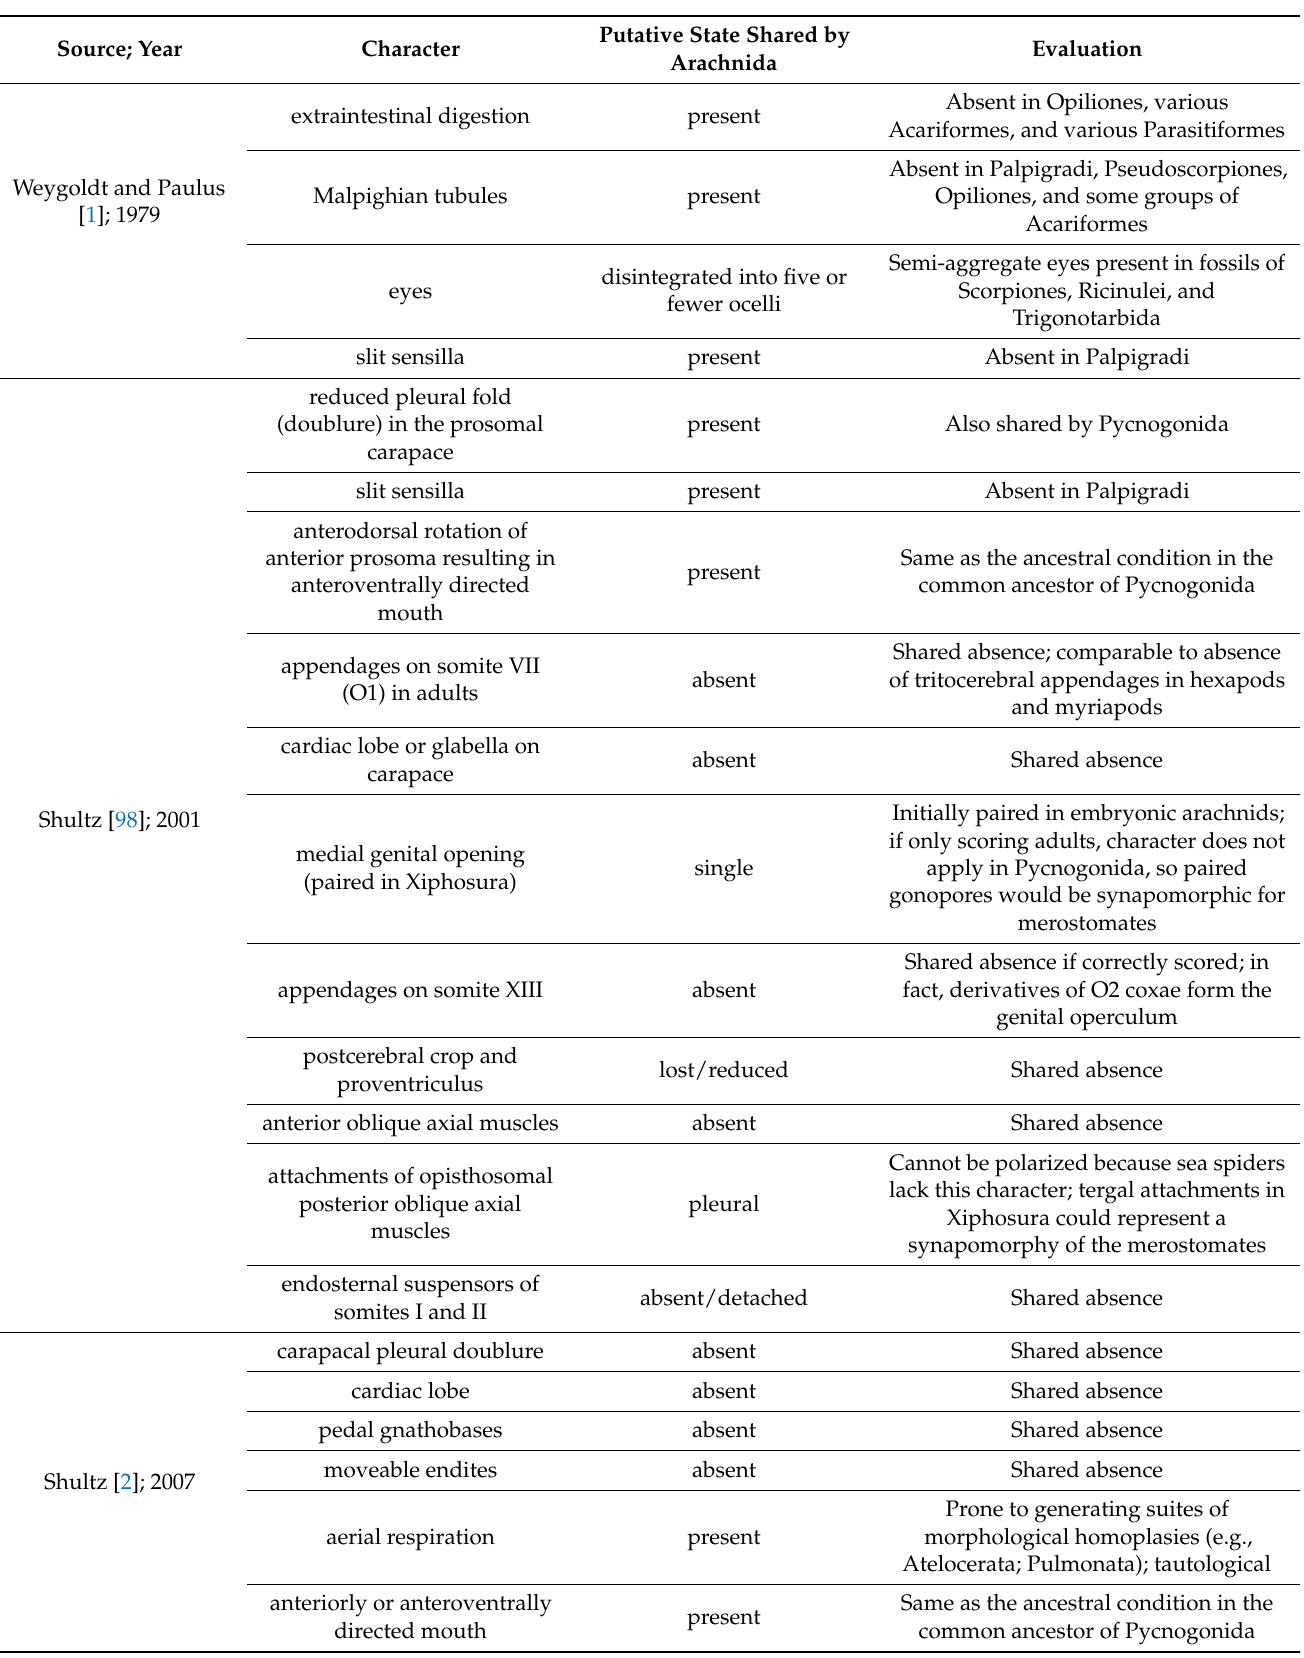
Table 1. There is no compelling morphological support for the monophyly of Arachnida. Tabulation and critical evaluation of putative synapomorphies historically uniting